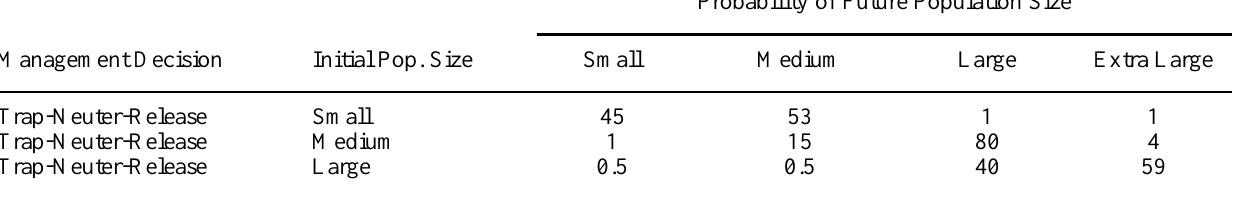
Table 1 . An example of a Conditional Probability Table (%